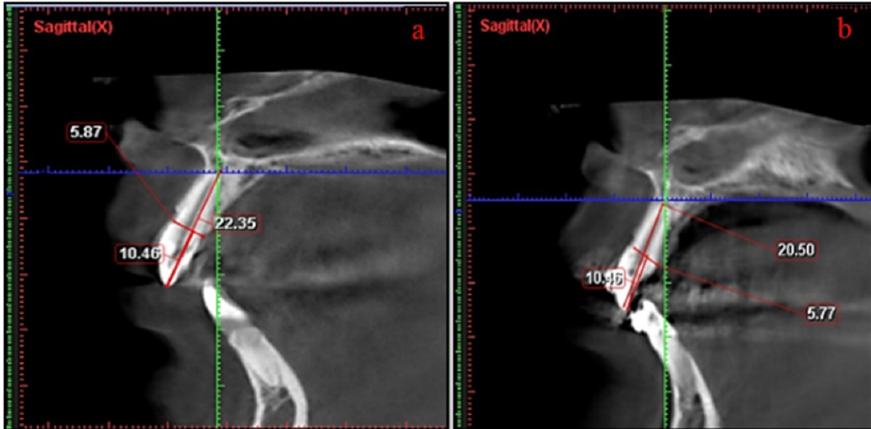
Figure 3. Measurements of root resorption ( a ) Sagittal view of CBCT showing the pre-measurement of root length ( b ) Sagittal of CBCT showing the post-measurement of root length.